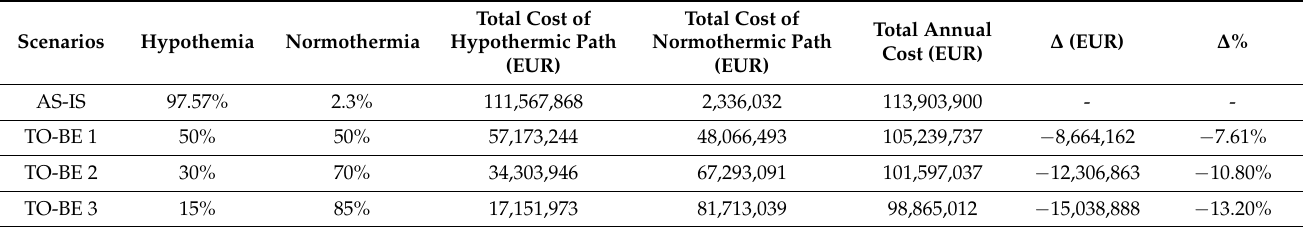
Table 5. Economic evaluation—Budget Impact Analysis (BIA).